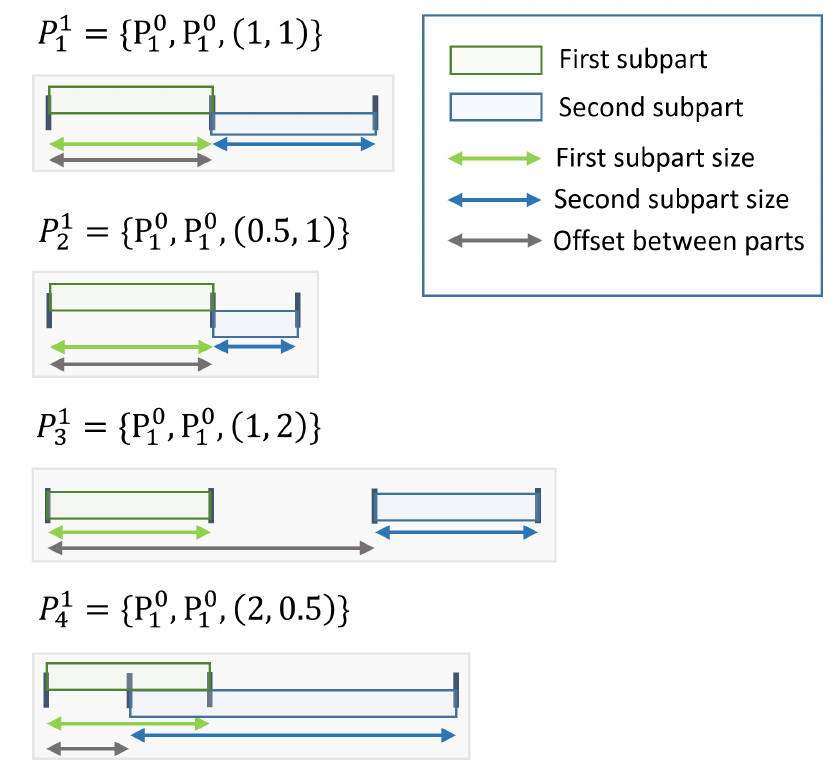
Figure 3. An example of four different RhythmCHM compositions. In the first example, the second subpart is the same length as the first subpart and is positioned exactly one P 0 subpart’s position. In P 1 , the second subpart is the same length as the first subpart and occurs at twice 2 its length. In P 1 , the second subpart is twice the length of the first subpart and starts at half its length. 3 In P 1 , the second subpart is half the length of the first subpart and starts exactly at its end. The green 4 arrow represents the length (1) of the first subpart, while the blue arrow represents the length of the second subpart. The offset of the second subpart is marked with a gray